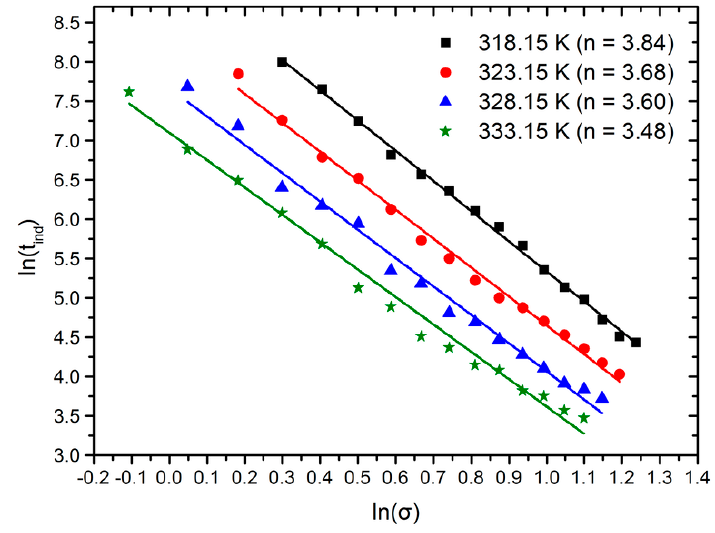
Figure 4. Plot of log(t ind ) versus l𝑛(σ) for Li 2 CO 3 crystallization.